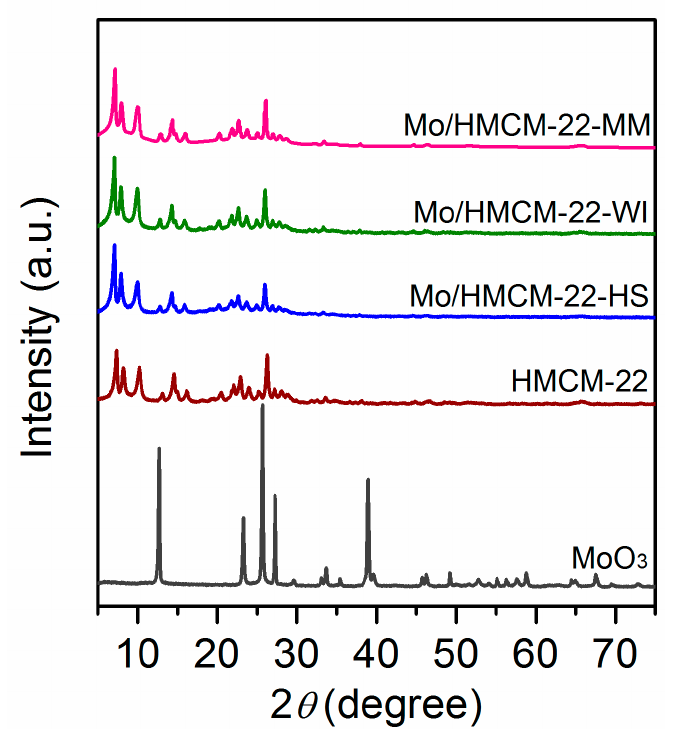
Figure 2. X-ray diffraction (XRD) patterns of MoO 3 , HMCM-22 zeolite and various Mo/HMCM-22 catalysts.